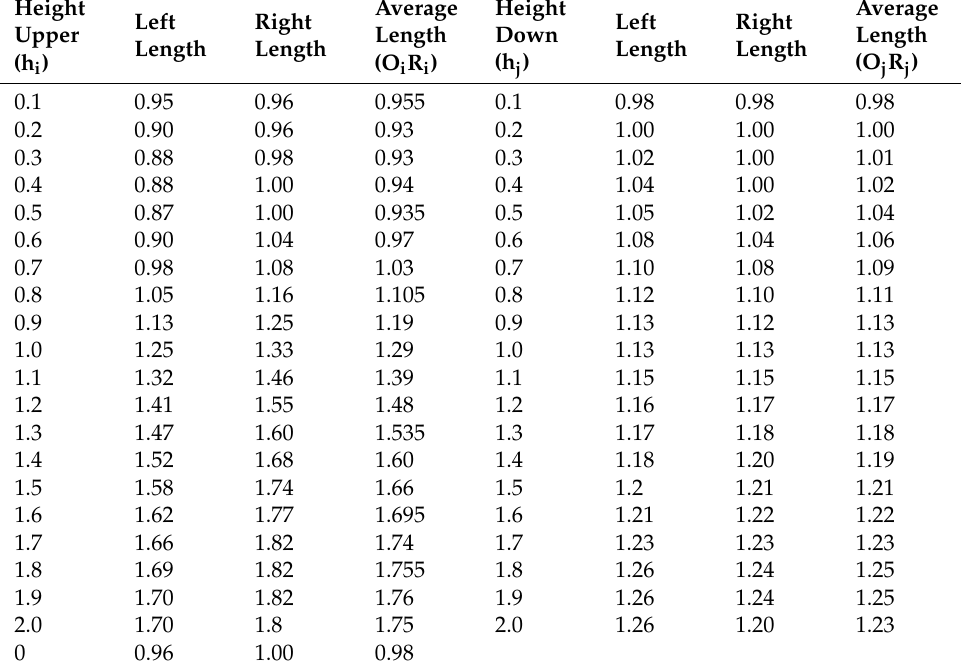
Table A2. Cross-sectional profile of case S3 weld seam. (Unit: